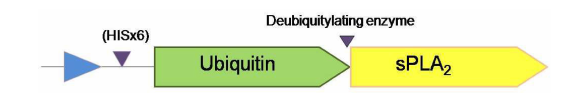
FIGURE 1 | Schematic representation of the system applied for Gm sPLA 2 s expression and purification. Triangles indicate the position where is the polyHIS-tag motif and the position where the deubiquitylating enzyme cut in order to release the protein with its native N-terminus without any extension.